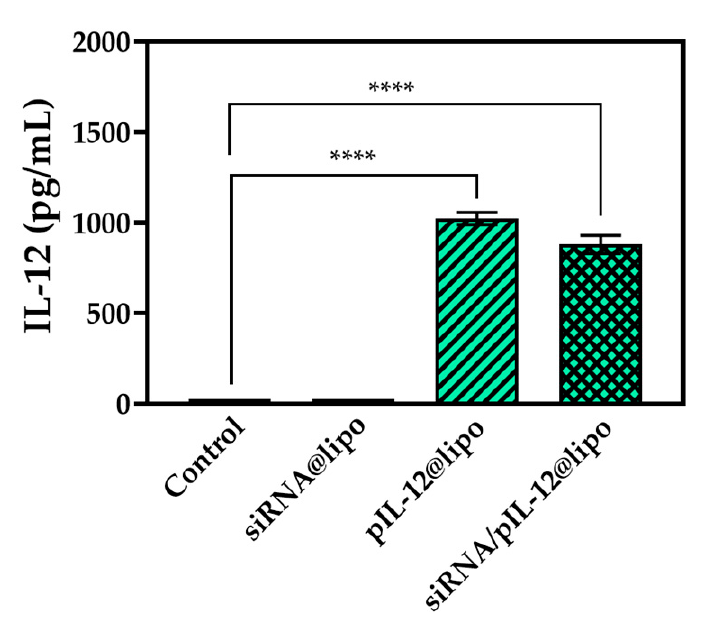
Figure 4. The IL-12 concentration in the culture supernatants of HepG2.215 cells treated with siRNA- and/or pIL-12-loaded complexes for 48 h at the siRNA concentration of 60 pmol/mL and/or the pIL-12 concentration of 1 µ g/mL. HepG2.215 cells without treatment were used as a control (**** p < 0.0001; n = 3).